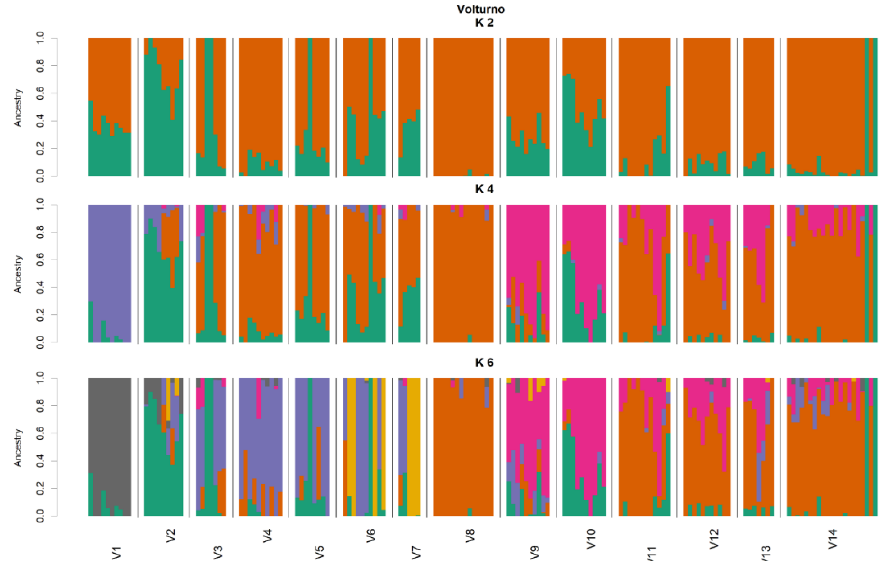
Figure 7. ADMIXTURE results at K = 2, K = 4 and K = 6 on Volturno genotyping data. Assignment of single individuals (thin vertical bars) to different clusters. Different colors identify different clusters. The reconstruction at K = 4 had the smallest cross-validation error (see Figure S1).